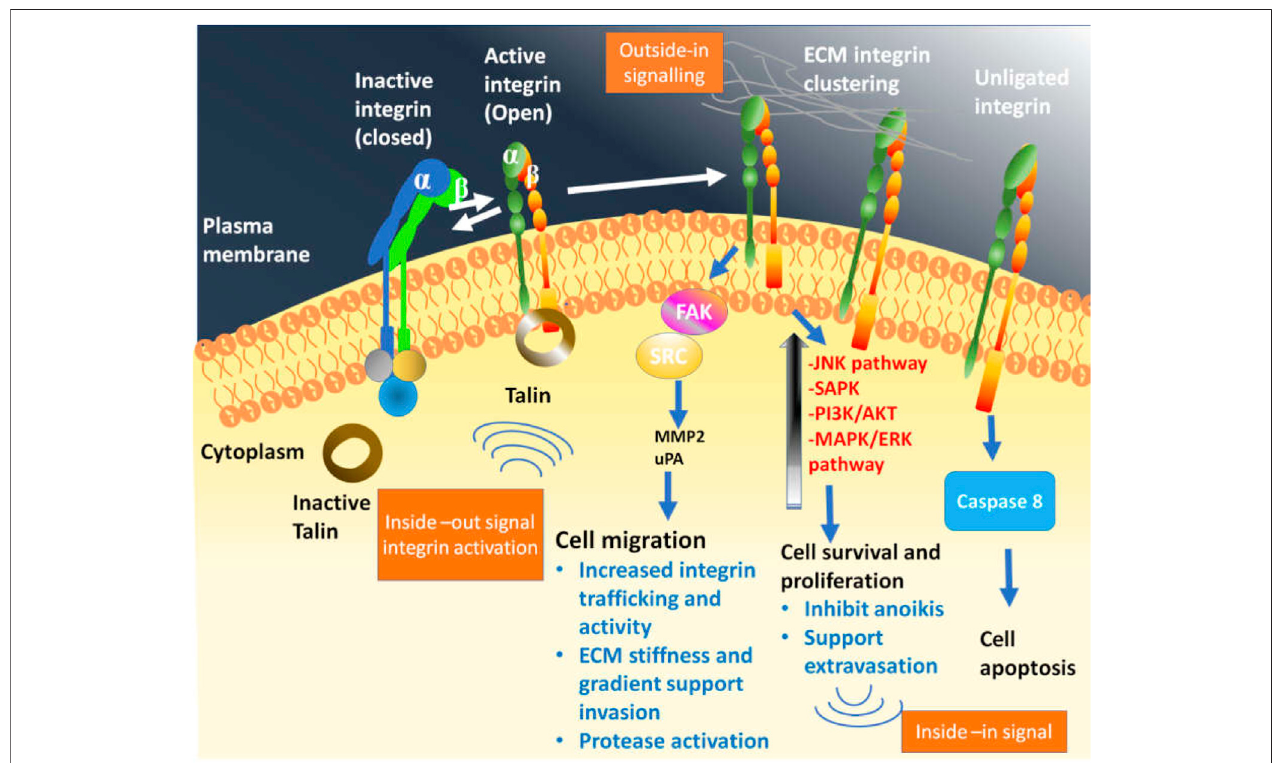
FIGURE 2 | Bidirectional signalling byintegrin family which isin virtue to con fi rmational state demonstrate its binding af fi nity towards extracellular matrix (ECM) and relatedprotein. Thebend or closed integrin epitomize the inactive form having low af fi nity towards ECM, whilethe straight-extended and upright integrin corresponds to the active form that show high af fi nity towards ECM, thereby promoting down-stream signalling eliciting cellular response following the ligand attachment. Following the integrin-ligand engagement also called as adhesion, and their clustering on plasma membrane, assembles the multimeric complexes to promote outside-in or downstream signalling. In consequence, phosphorylation of focal adhesion kinase (FAK) initiates, which further activate the steroid receptor coactivator or SRC. In associationtothis,othermetabolicpathway-PI3K/AKT,MAPK/RASalsogetactivated toproduce signalnodes. Talinbindtothe β -integrinsubunittailwhichtriggersthe openstructure.Moreover,integrindependentsignallingcompoundsandactivatedintegrininassociationwithreceptortyrosinekinaseandECMencouragesthe “ inside- in ”